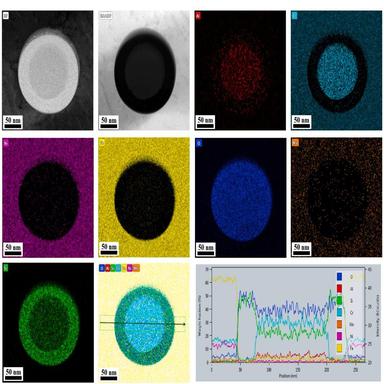
The HR-STEM/EDS elemental maps for complex nanoparticles.